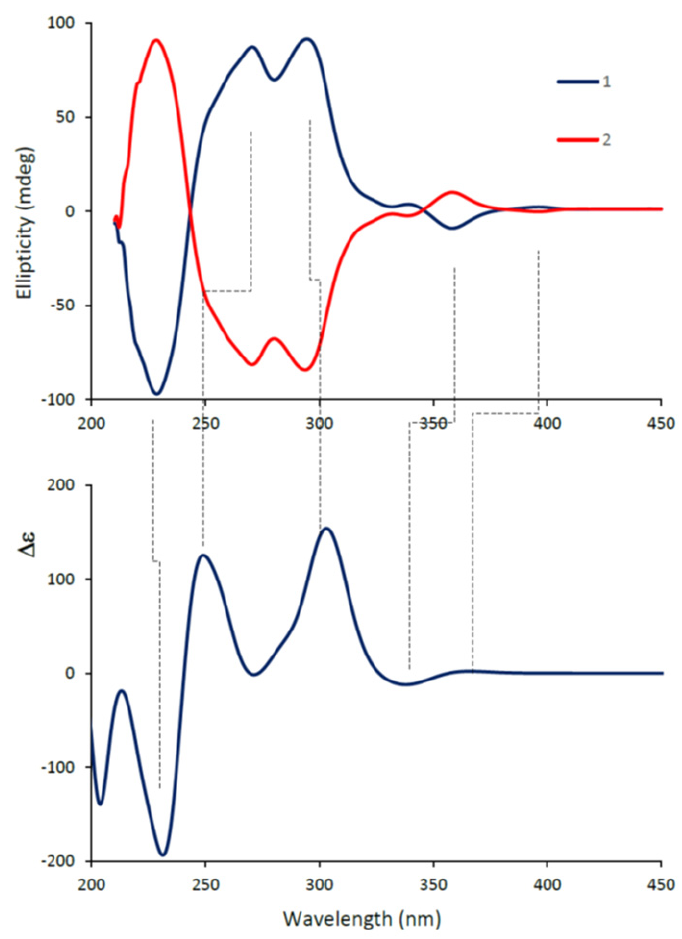
Figure 4. ( top ) Experimental CD spectra for the two enantiomers of 2a . ( bottom ) Calculated CD spectrum for the P structure of 2a at M06-2X/cc-pvtz level, bandwidth 0.2 eV, wavelength shift +25 nm.